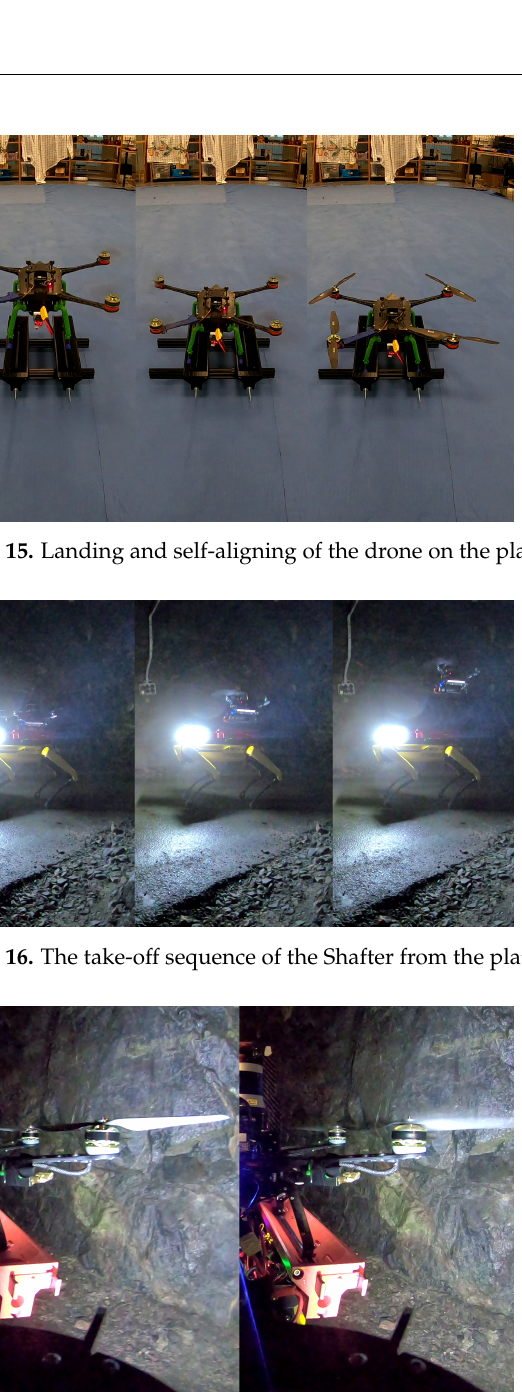
Figure 17. Unlocking sequence of the Shafter drone from the platform. The drone is locked ( left ); the drone is unlocked and ready to take off ( right